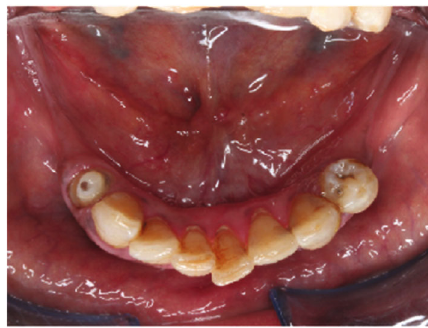
Figure 13: Metal ceramic crown preparation on (FDI 44).